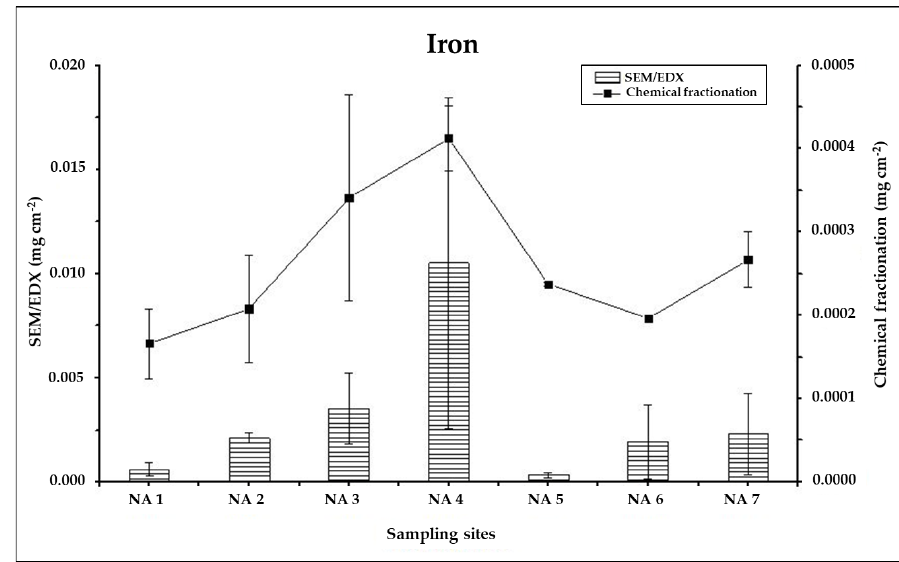
Figure 8. Comparison between total PM load (mg cm − 2 ) detected through the chemical fractionation procedure (Soluble + Insoluble fraction) and through SEM / EDX, in Naples samples. Each bar represents the mean of N = 2 replicates ± standard deviations.